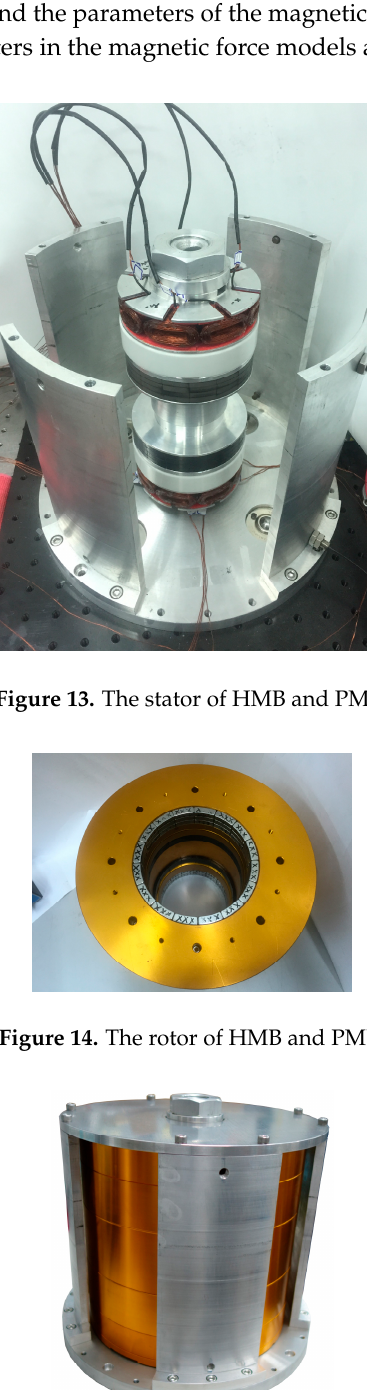
Figure 15. The assembled FESS prototype. Table 1. Parameters of proposed FESS prototype.